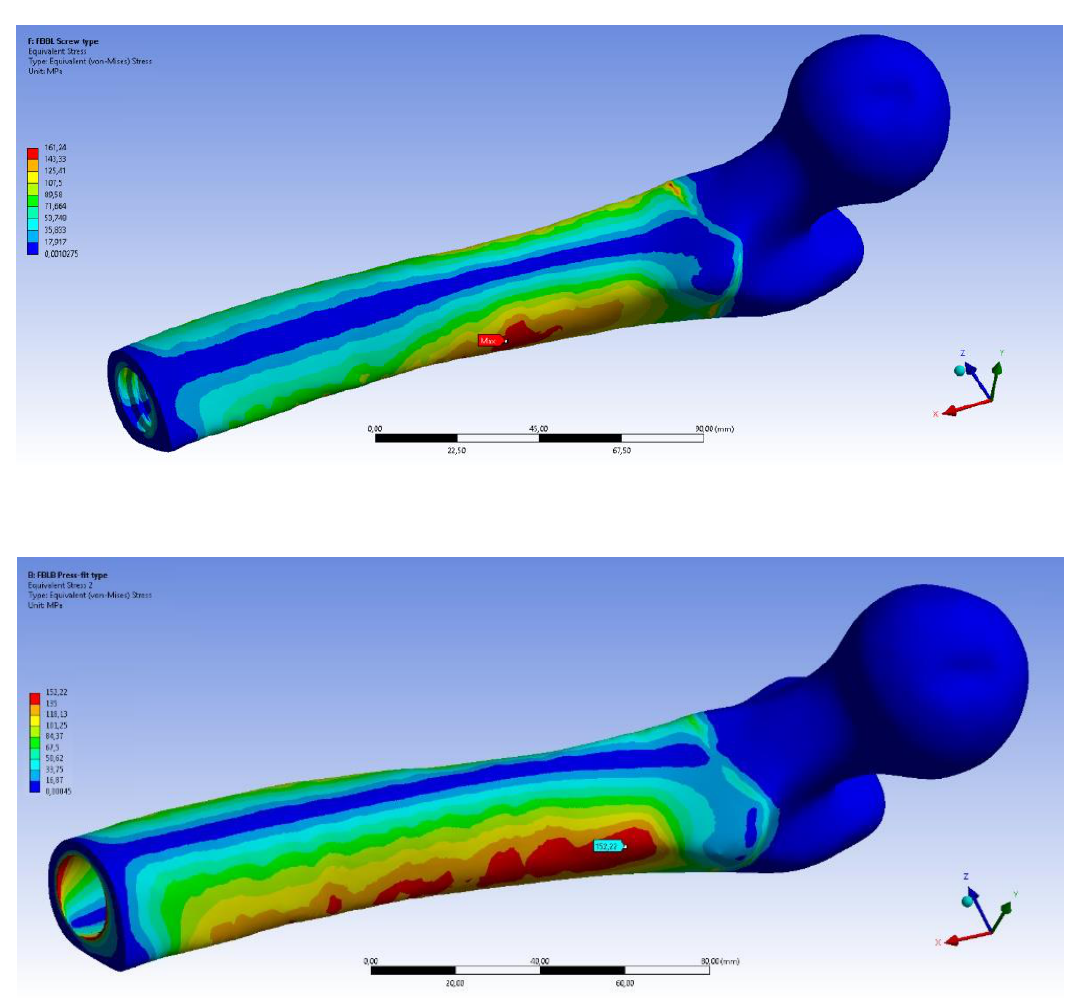
Figure 10. Fall Backwards with Balance Loss (FB BL) scenario: von Mises stress distribution on the OPRA ( top ) and the OPL ( bottom ) prosthesis